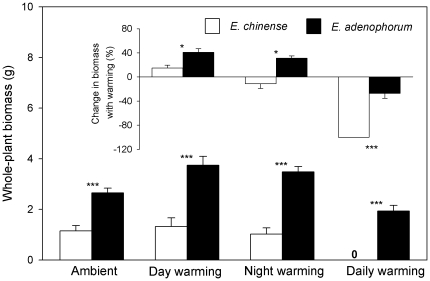
Whole-plant biomass of the invasive plant Eupatorium adenophorum and the native plant Eupatorium chinense grown in four different air temperatures, and changes in whole-plant biomass with warming for both species (embedded smaller panel inside).Data are means+1 SE. * P<0.05; *** P<0.001.